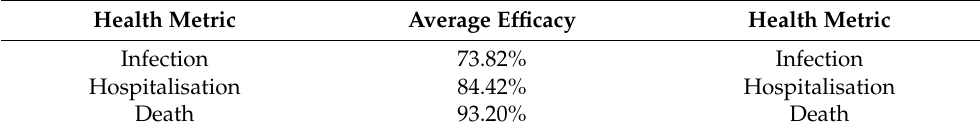
Table A4. Average efficacy estimates for COVID-19